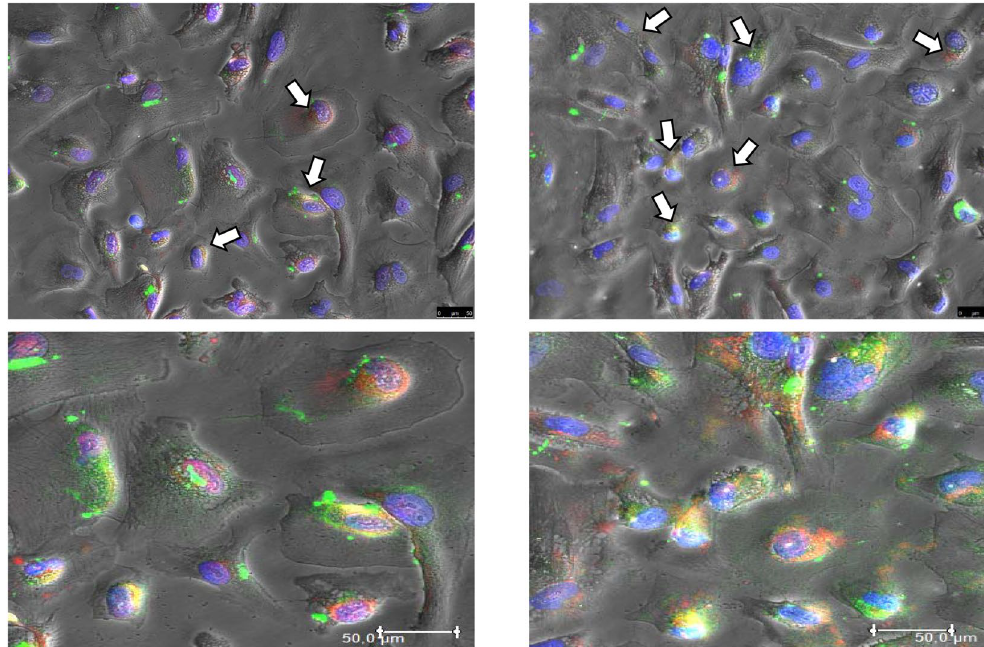
Figure 3. Albumin colocalizes with megalin and cubilin in human podocytes. Immunolabeling shows colocalization (in yellow/orange) of megalin (left) and cubilin (right) with albumin after 24 hours of incubation. Lower panel are zoom-in of respectively upper images. Statistical analysis using Pearson’s coefficient ( Rr ) with LAS-AF software disclosed a significant correlation between cubilin and FITC-BSA ( Rr = 0.71), and a non- significant correlation between megalin and FITC-BSA ( Rr = 0.45). Green: FITC-BSA; Red: megalin (left) or cubilin (right); White arrows indicate colocalization. Blue: DAPI. Objective 20X/0.4. Scale bar 50 µ